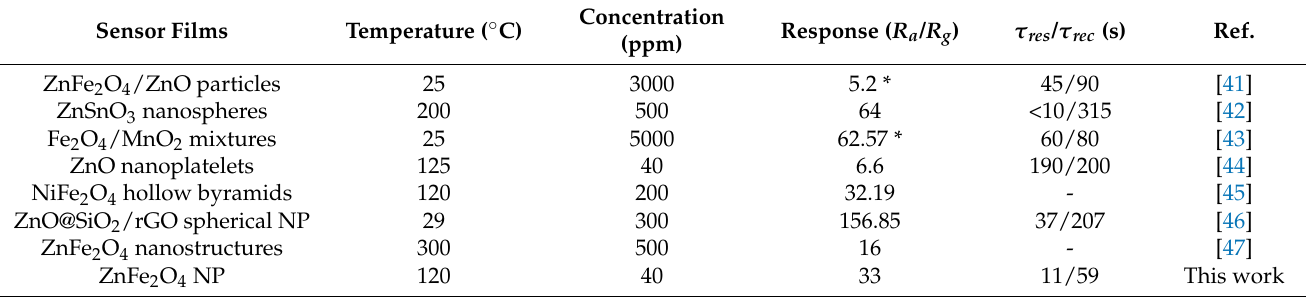
Table 1. Comparison of the ZnFe 2 O 4 NP sensing layer produced at 2.0 µ L to other propanol gas sensing layers. Sensor